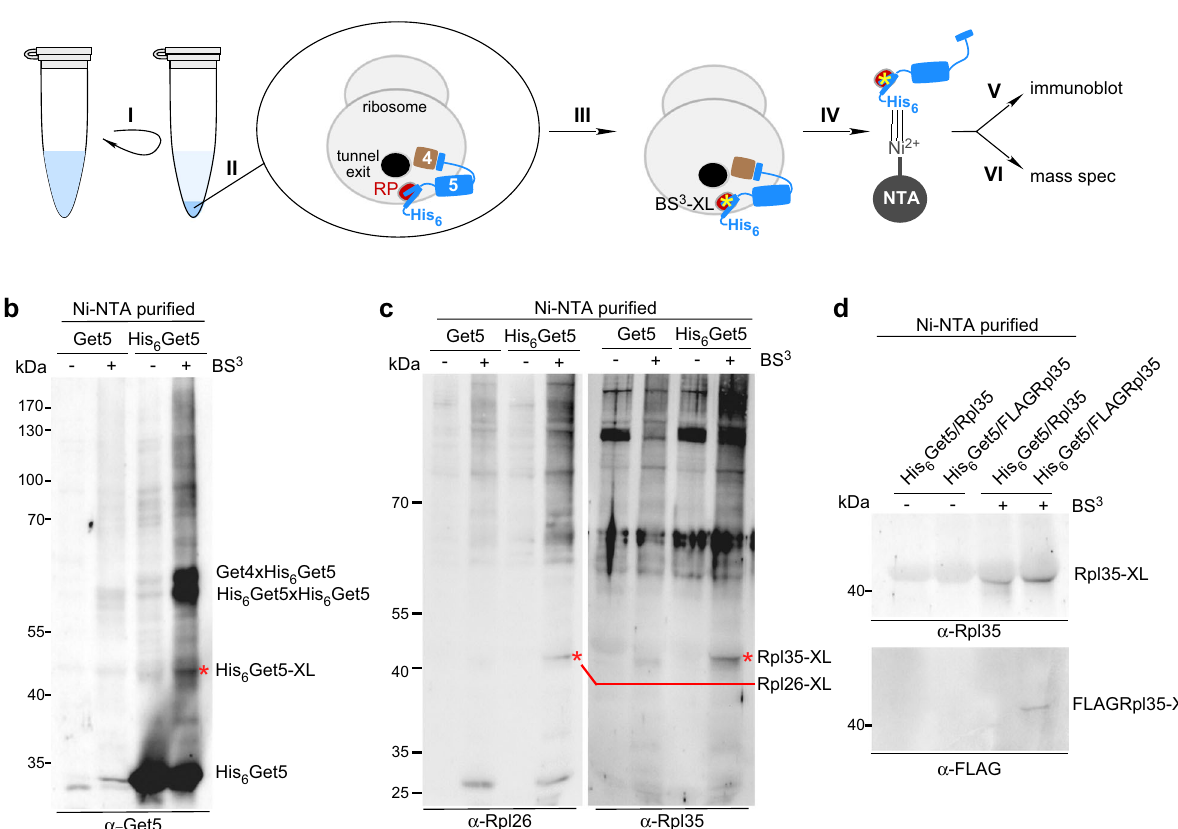
Fig. 2 Ribosome-bound Get5 contacts Rpl26 and Rpl35 at the ribosomal tunnel exit. a Crosslinking analysis of ribosomal protein contacts. Ribosomes in total cell extract were (I) collected via centrifugation, (II) resuspended in low salt buffer, and (III) crosslinked with the homobifunctional, amino reactive crosslinker BS 3 . (IV) The crosslinked material was denatured and subsequently His 6 Get5-containing crosslink products were isolated via Ni-NTA puri fi cation (see Methods). His 6 Get5 and crosslinked proteins, termed Ni-NTA puri fi ed His 6 Get5, was analyzed (V) via immunoblotting with antibodies recognizing candidate ribosomal proteins and (VI) via mass spectrometry (see Supplementary Fig. 2). For simplicity, only one heterodimeric subcomplex of the Get4 2 Get5 2 tetramer is depicted in all cartoons. b , c Immunodetection of Get5 crosslink products. His 6 Get5, with or without crosslinking, was puri fi ed via Ni-NTA as described in a from cells expressing either His 6 Get5, or, as a control, untagged Get5. Aliquots of the indicated samples were analyzed via immunoblotting with α -Get5 ( b ), α -Rpl26, or α -Rpl35 ( c ). Red asterisks indicate crosslink products, recognized by α -Get5 (His 6 Get5-XL in b ), α -Rpl26, or α -Rpl35 (Rpl26-XL, Rpl35-XL in c ). Crosslink products between His fi cation 6 Get5 and Get4 subunits are indicated (see also Supplementary Fig. 2b). d Identi of Rpl35 as a crosslink partner of Get5. Ni-NTA puri fi ed His 6 Get5 was generated as described in panel a from cells coexpressing His 6 Get5 and FLAG- tagged Rpl35 (FLAGRpl35). Aliquots were analyzed via immunoblotting with α -Rpl35 (upper panel) or α -FLAG (lower